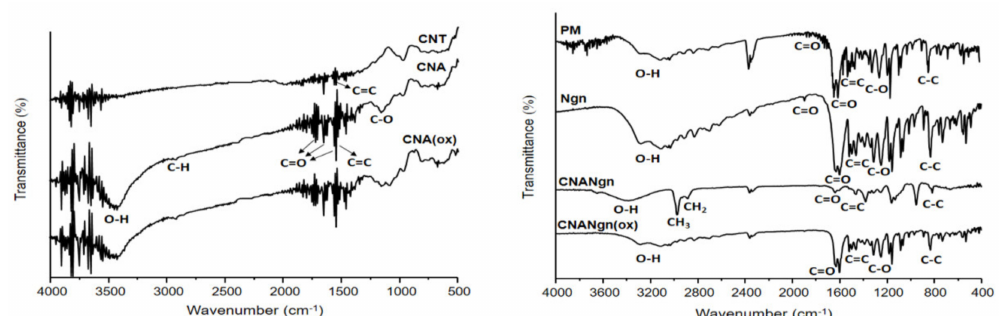
Figure2. FTIR(Fourier-TransformInfraredSpectroscopy)spectraofCNT(carbonnanotube), CNA(CNT after acid treatment), CNA(ox) (CNA submitted to oxidative environment), CNANgn (CNA treated with naringenin), CNANgn(ox) (CNA treated with naringenin in oxidative environment), PM (physical mixture of CNA and naringenin) and Ngn